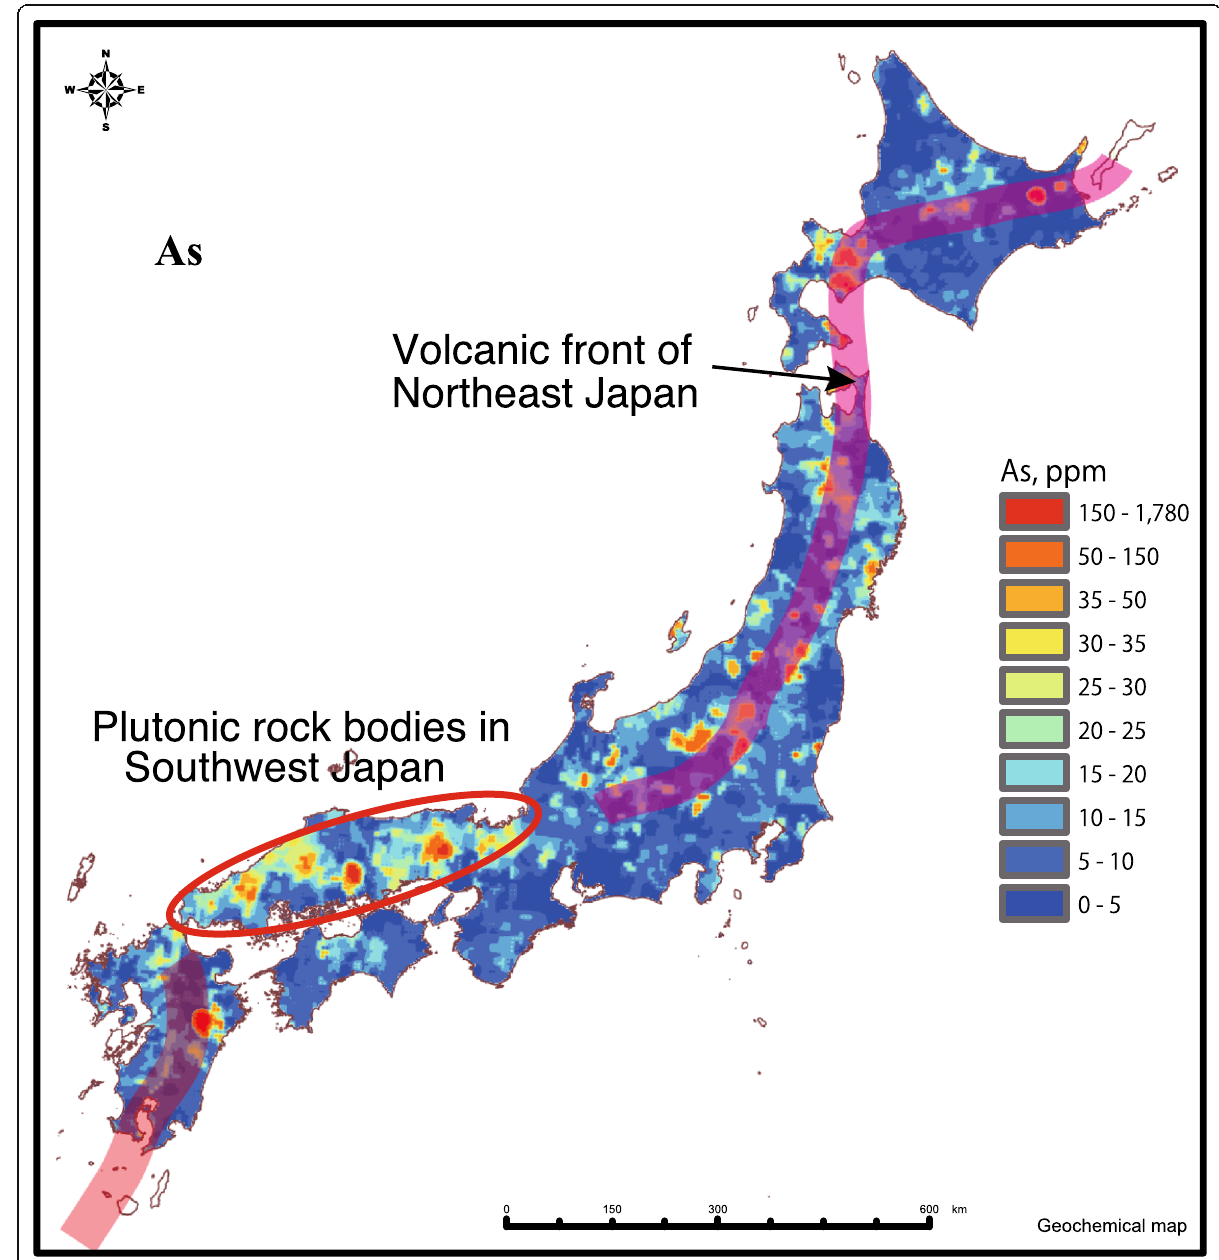
Fig. 3 Geochemical map showing arsenic distribution of riverbed sediments of Japan (Imai et al. 2004). The areas indicating volcanic fronts and plutonic rock ranges are added for this